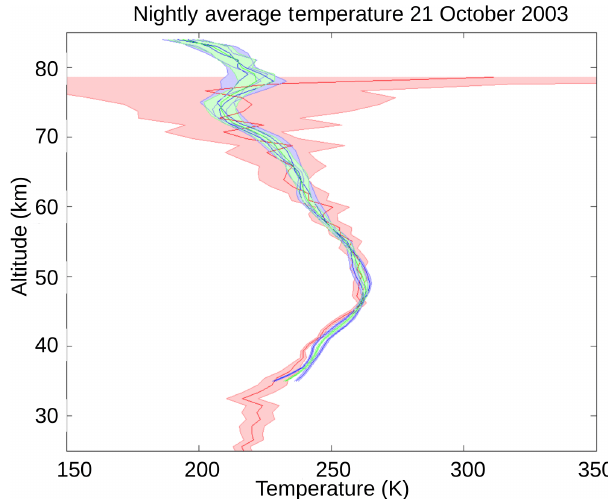
Figure 2. Temperature profiles processed for the same occultation as in Fig. 1. The horizontal bar indicates the dispersion (1 standard deviation) between the six individual profiles.